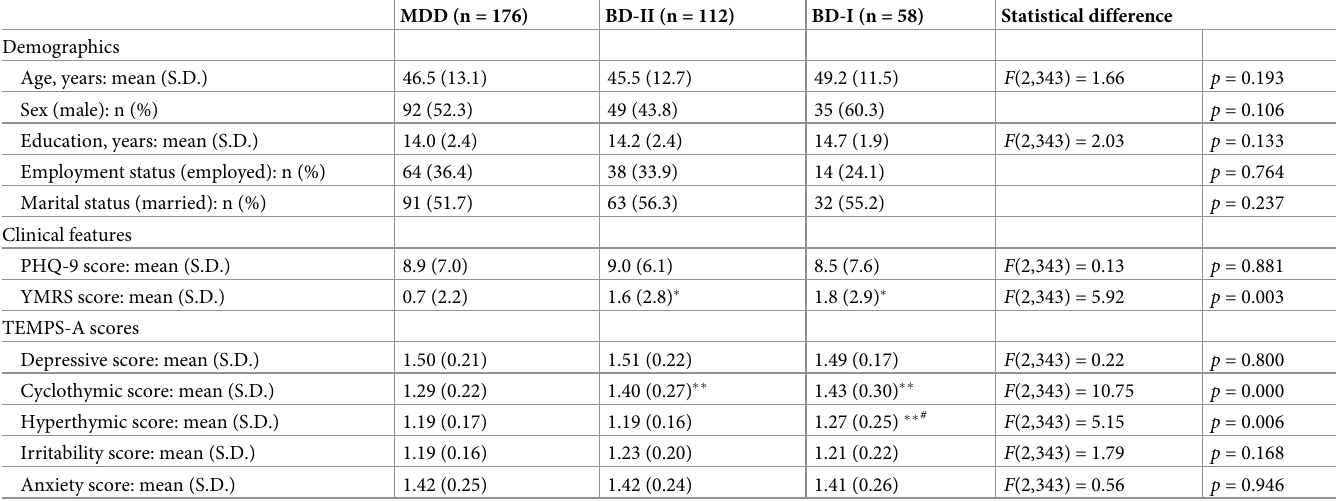
Table 1. Demographic and clinical characteristics and TEMPS-A scores of the patients analyzed in this